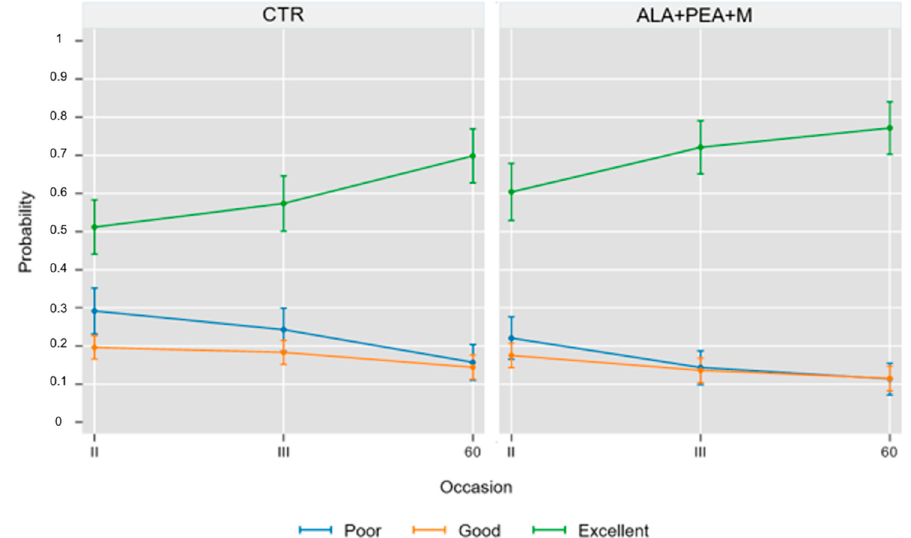
Figure 2. Time-related changes in the proportion of patients with a poor, good, and excellent outcome in the control O 2 -O 3 (CTR) and O 2 -O 3 + ALA (ALA) groups. Values are proportions and 95% cluster confidence intervals from ordinal logistic regression (see statistical analysis for details).